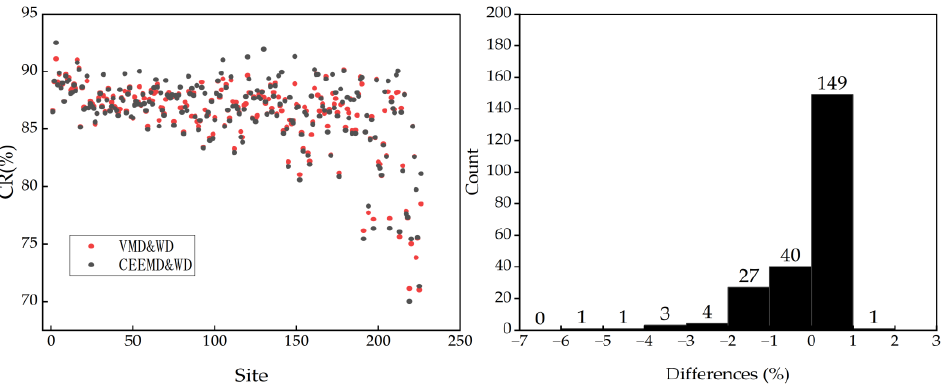
Figure 7. The differences of CRs between CEEMD & WD and VMD & WD.